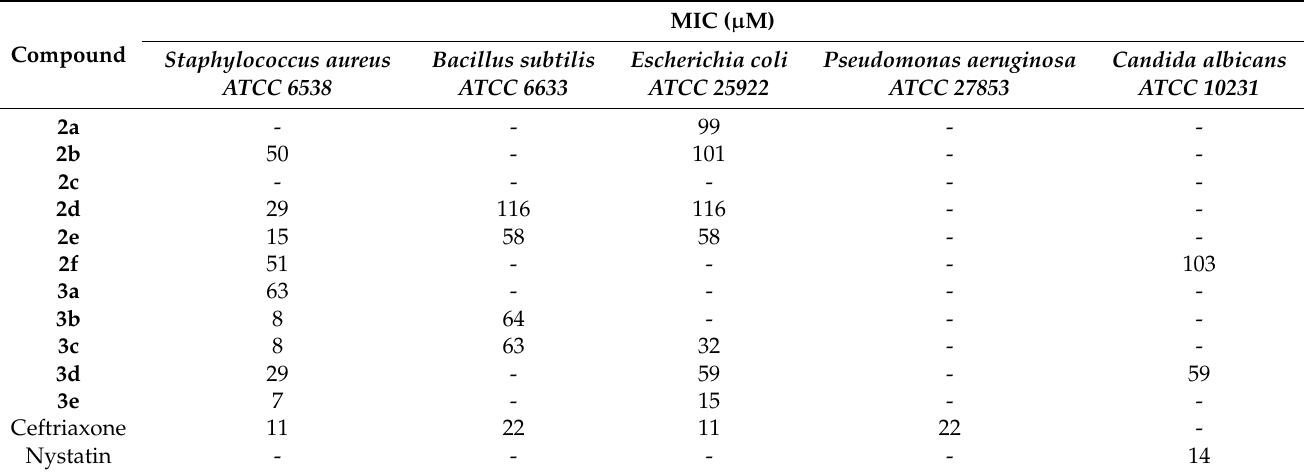
Table 4. Minimum inhibitory concentration (MIC) of test compounds in relation to reference test